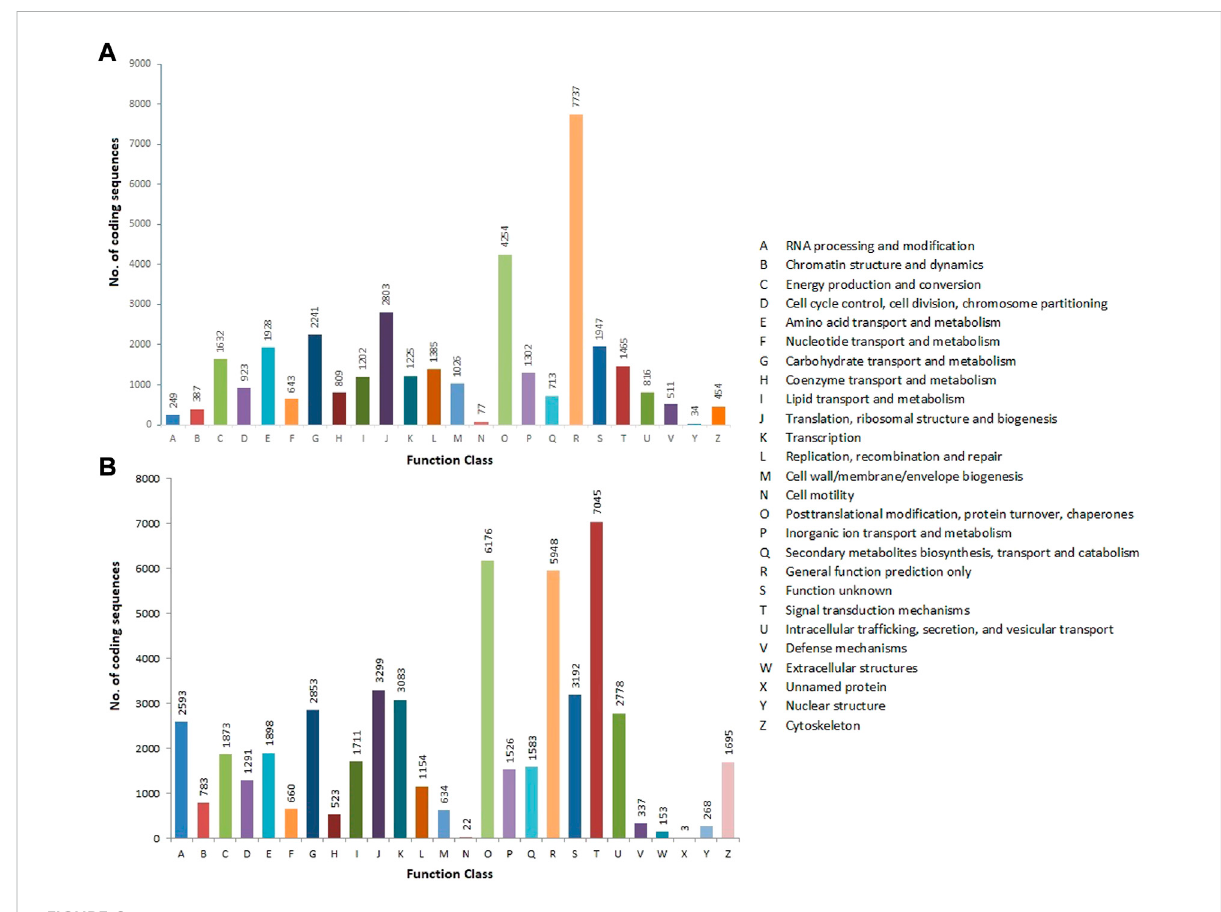
FIGURE 6 COG (A) and KOG (B) functional classi fi cation of allohexaploid Brassica coding sequences. The y -axis indicates the number of coding sequences in a speci fi c functional cluster. The x -axis indicates the functional classes.